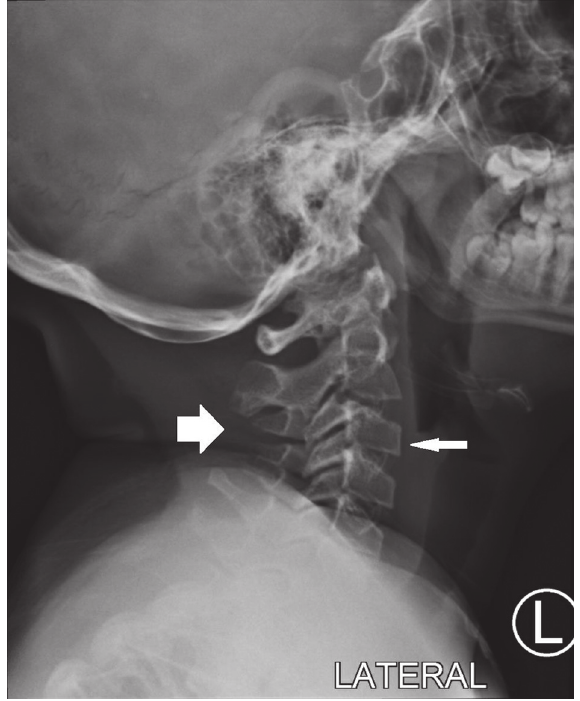
Figure 2: The cervical spine visualized to the C5 level. The ver- tebrae are diminished in height and dysmorphic in appearance (thick arrow). There is anterior wedging (thin arrow).